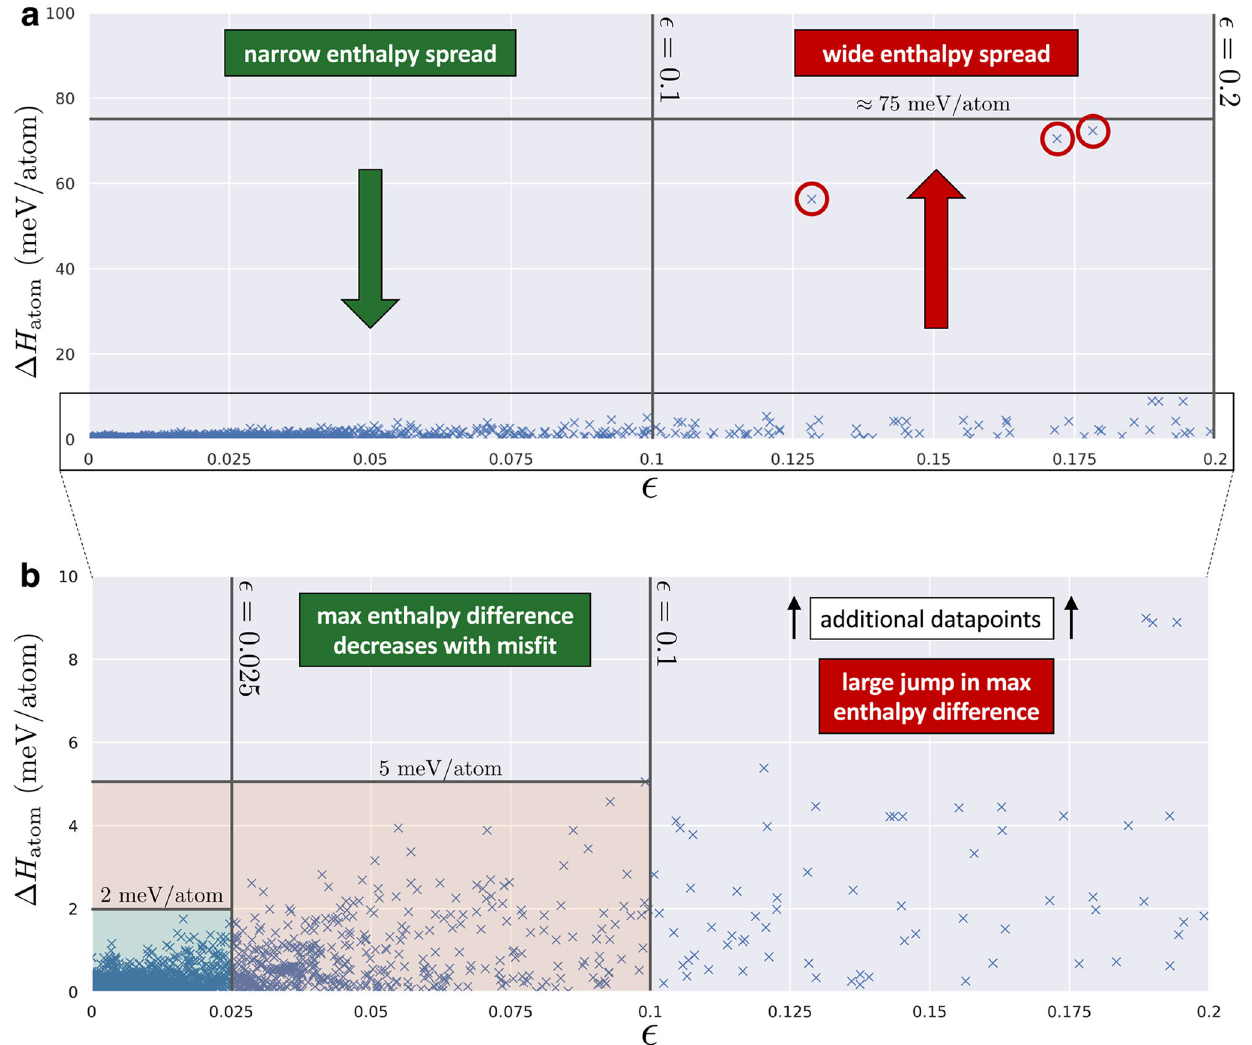
Fig. 6 Enthalpy difference per atom and mis fi t value between compared structures in the AFLOW-ICSD catalog. The mis fi t value ( ϵ ) and H test ) for all AFLOW-ICSD entries with similar parameters are shown above. The plots the difference in enthalpy per atom ( Δ H atom ¼ H ref atom (cid:3) atom show the mis fi t values between 0 and 0.2 with two enthalpy difference ranges (for clarity): a 0 − 100 meV/atom and b 0 − 10 meV/atom. The plot with the full mis fi t domain and enthalpy range is shown in Supplementary Fig. 1. Candidate mis fi t thresholds are chosen based on the acceptable maximum enthalpy deviation between match structures. For example, mis fi t values below ϵ = 0.025 and ϵ = 0.1 (black vertical lines) are expected to yield enthalpy differences no larger than Δ H atom ≈ 2 meV/atom and Δ H atom ≈ 5 meV/atom, respectively (black horizonal lines). As the mis fi t values increase beyond ϵ > 0.1, the spread of the data points also increases. A large jump in the maximum enthalpy difference occurs at approximately ϵ = 0.125, indicating matched structures near this value and beyond are not guaranteed to have similar